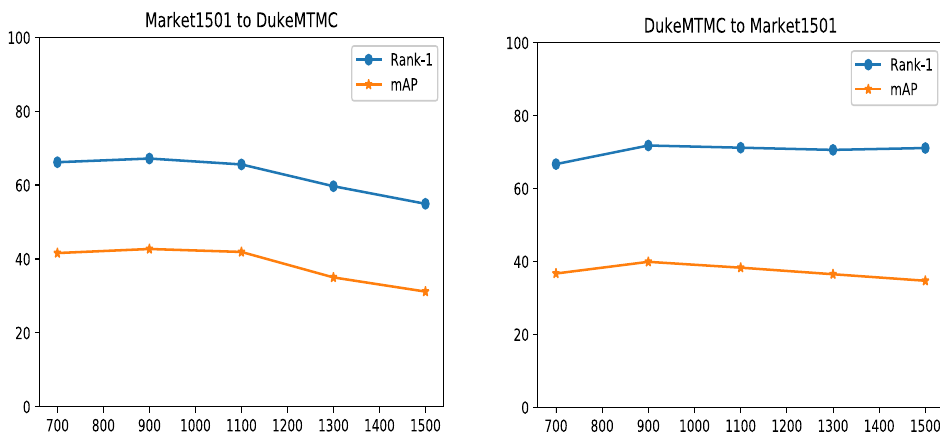
Figure 8. The influence of the number of cluster centers. The yellow line denotes mAP, and the blue line denotes Rank-1